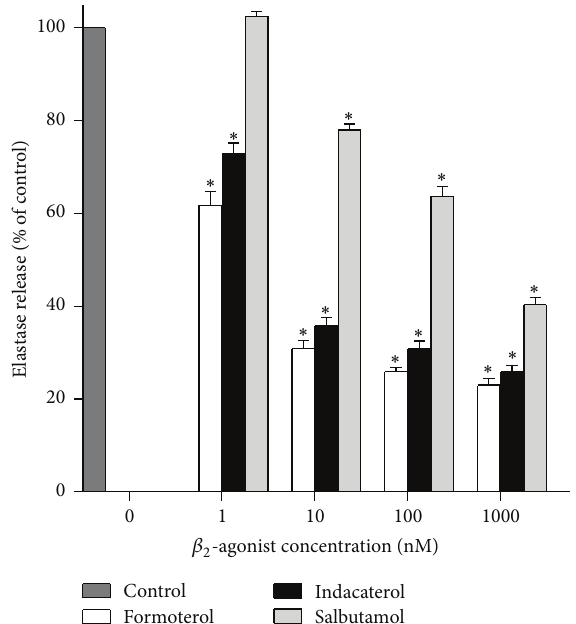
Figure 3: Effects of formoterol, indacaterol, and salbutamol (1– 1000 nM) on the release of elastase from neutrophils activated with N-formyl-L-methionyl-L-leucyl-L-phenylalanine (1 𝜇 M)/cyto- chalasin B (1 𝜇 M) (fMLP/CB). The results of 3 separate experiments ( 𝑛 = 3 ) with 5 replicates for each drug concentration and control system in each experiment are expressed as the mean percentage of control ± SEM. The absolute values for the unstimulated control systemandforcellsactivatedwithfMLP/CBwere 47±6 and 1551±78 milliunits elastase per 10 7 cells. ∗ 𝑃 < 0.0102 –0.0001 for comparison with the drug-free control systems.